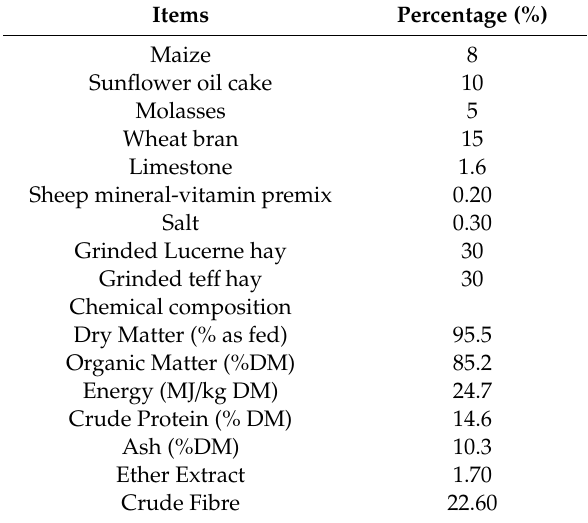
Table 1. Ingredients and chemical composition of the basal diet fed to Dohne-Merino sheep.